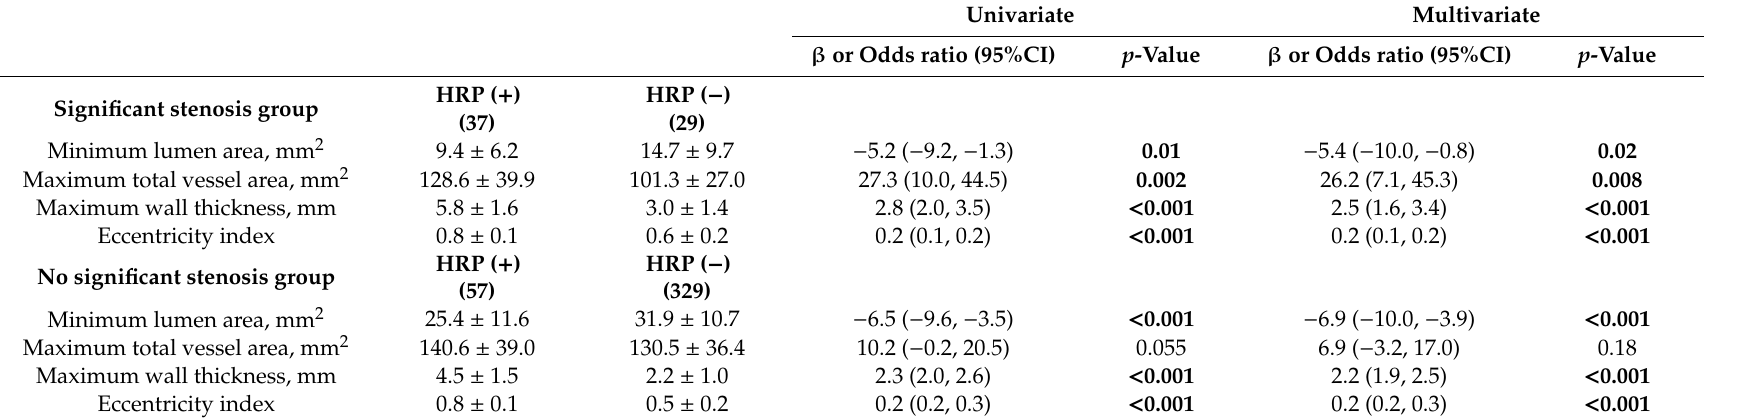
Table 2. Comparison plaque morphology between high-risk plaque (HRP) ( + ) and ( − ) arteries.